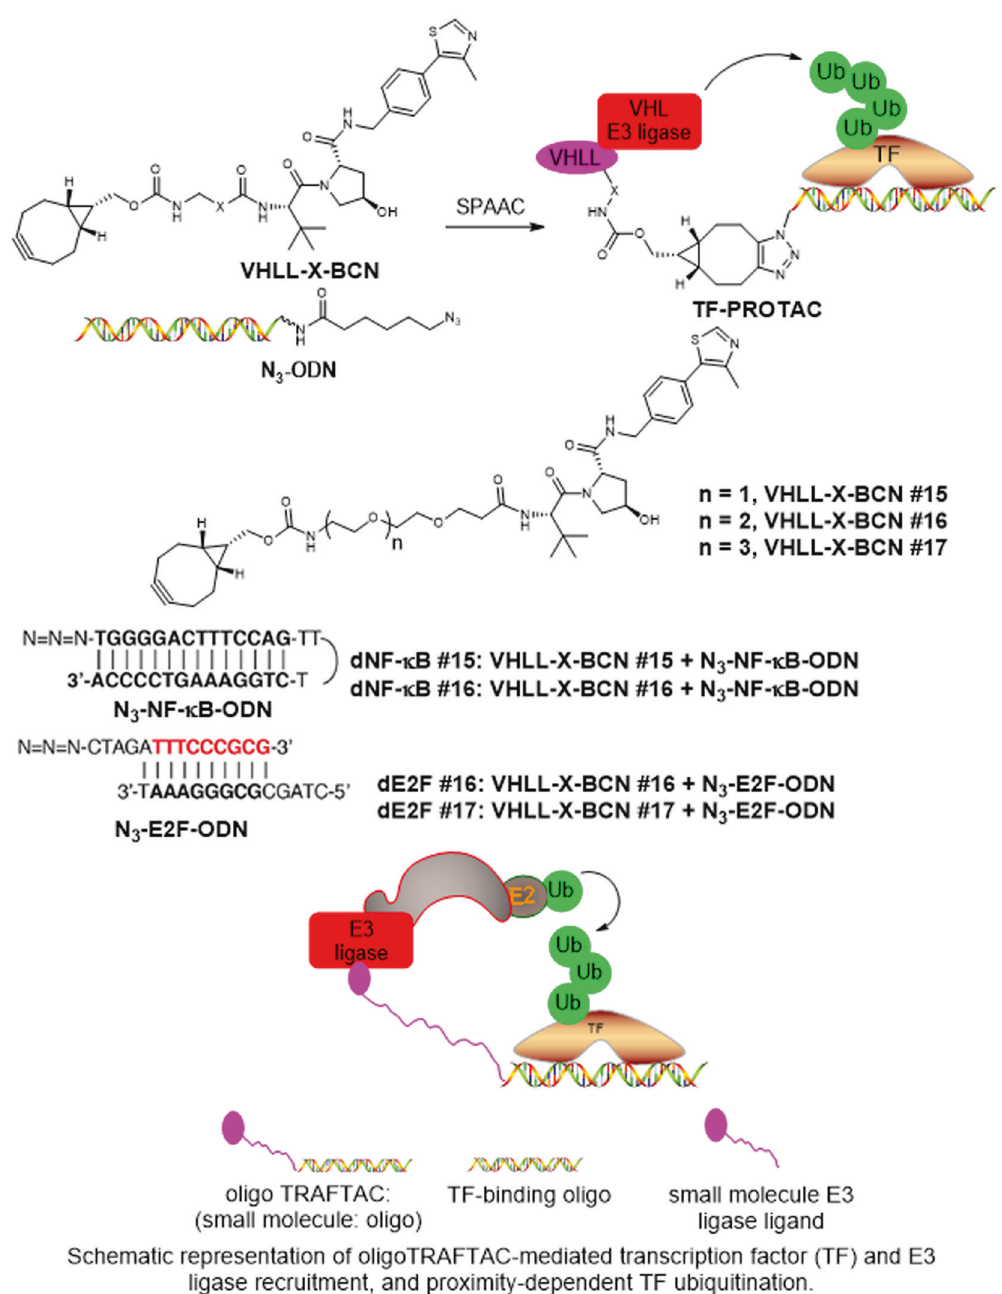
Fig. 86 The representative PROTACs of TF-PROTACS